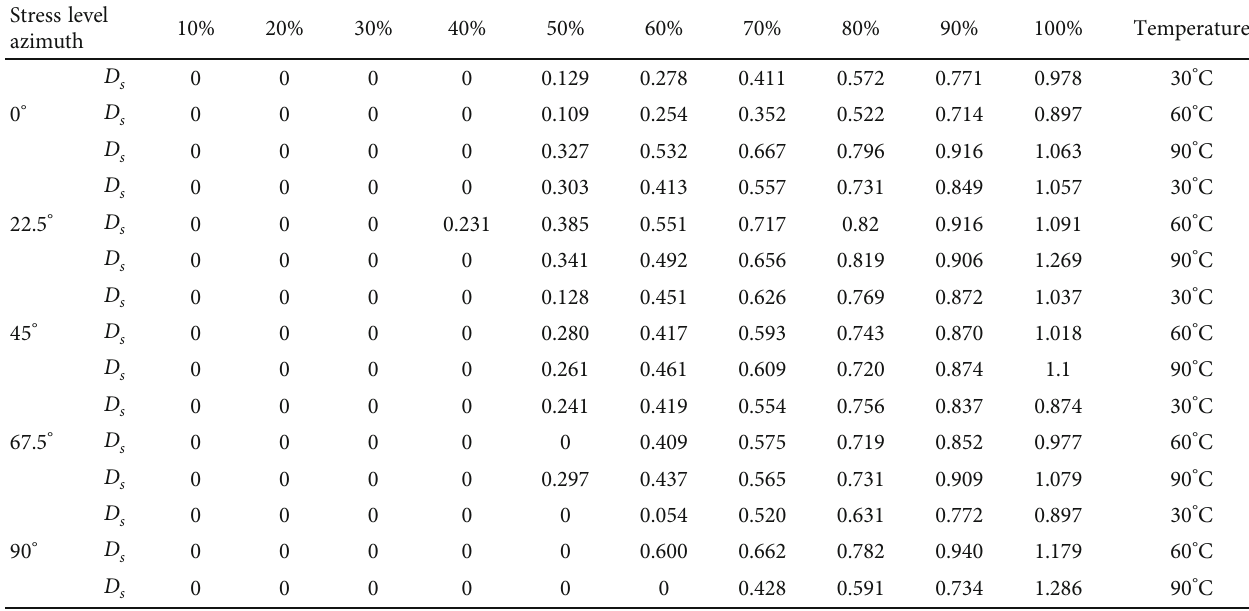
Figure 8: Fracture process and acoustic emission diagram of shale. (a) Crack initiation. (b) Crack propagation. (c) Instability mode. (d) Acoustic emission. Table 4: Fractal dimensions at di ff erent temperatures and stress